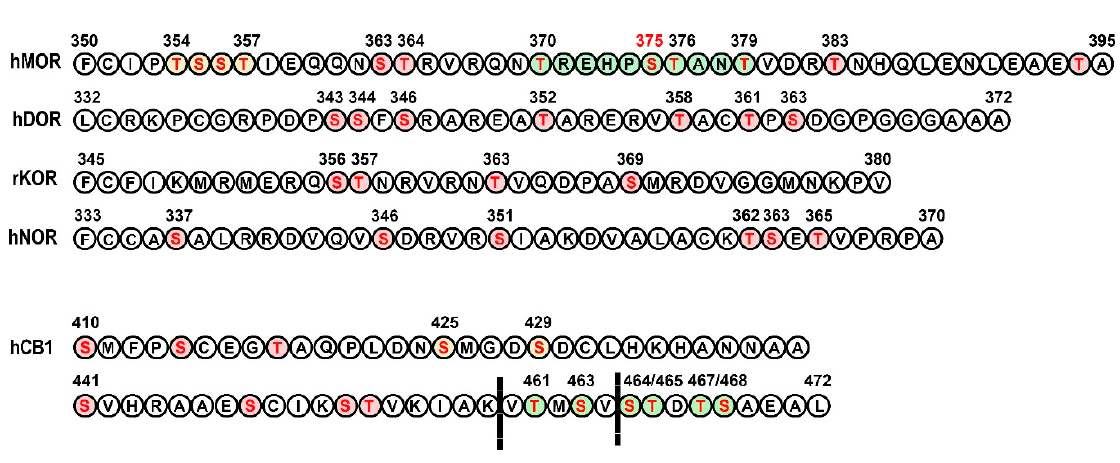
Figure 3. GRK phosphorylation sites in opioid and cannabinoid receptors. Top: C-termini of the four subtypes of human opioid receptors, with residue numbers indicated above. The phosphorylation of MOR was shown to be hierarchical, with Ser375 phosphorylated first, whereupon other residues within the stretch 370TREHPSTANT379 (highlighted in green) can be phosphorylated. Phosphorylation of another upstream cluster, 354TSST357 (highlighted in yellow), contributed to desensitization. Other phosphorylatable Ser and Thr are also shown (highlighted in pink). Bottom: The C-terminus of the human cannabinoid receptor CB1. Critical phosphorylation residues in the distal C-terminus are highlighted in green; the lines show the position of truncation of 10 or 14 terminal residues described in [122]. Two residues playing a key role in receptor desensitization, Ser425/Ser429 (Ser426/Ser430 in the rat), are highlighted in yellow; other phosphorylatable residues in pink. All putative phosphorylation sites are fully conserved in the human, rat, and mouse CB1.